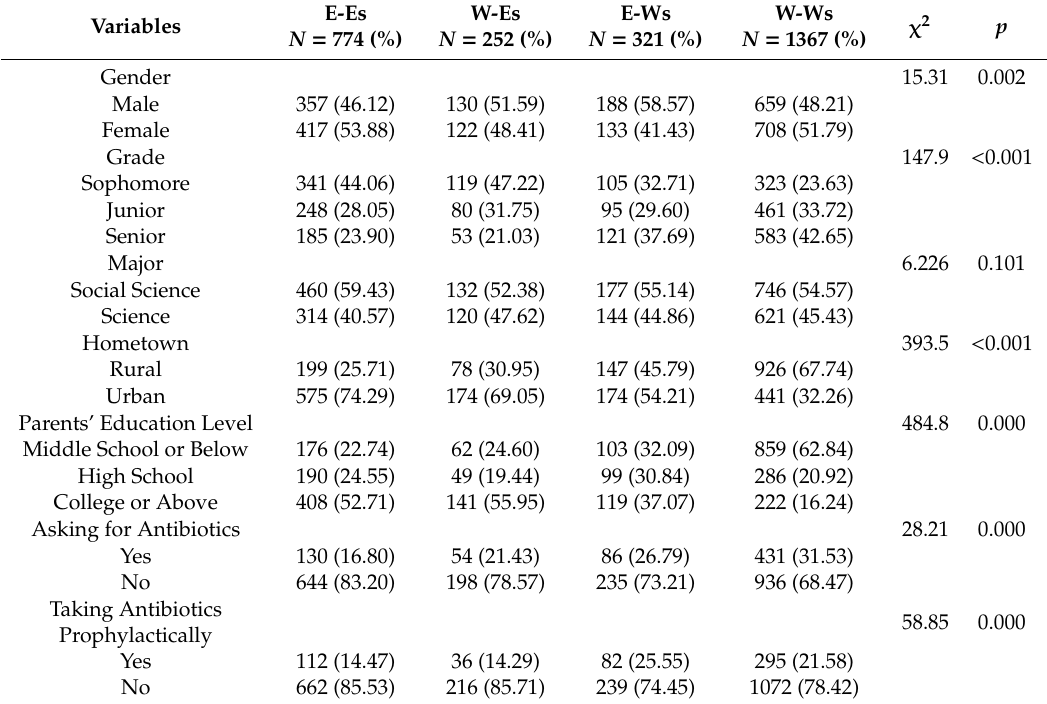
Table 2. Descriptive statistics for students stratified by regions and universities.